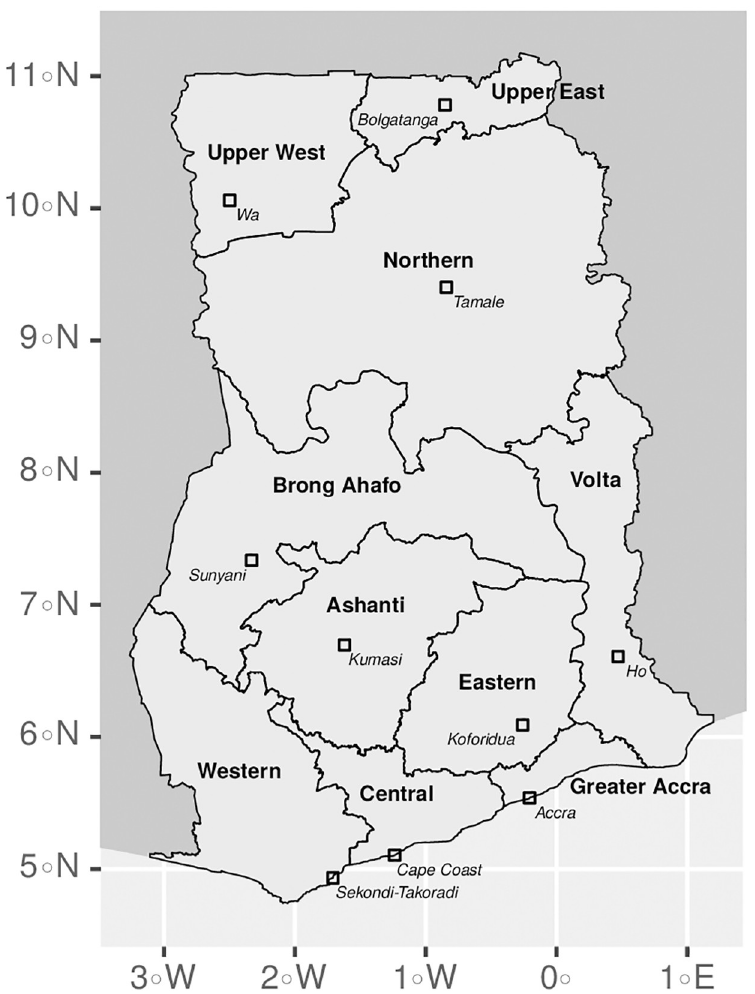
Fig 1. Administrative regions and regional capitals of Ghana. The regional boundaries shown are consistent with those in place during the study period (2010–2017), although the number of regions has subsequently increased to 16. Maps were created with data from the Humanitarian Data Exchange [33], which are made available under a CC-BY license